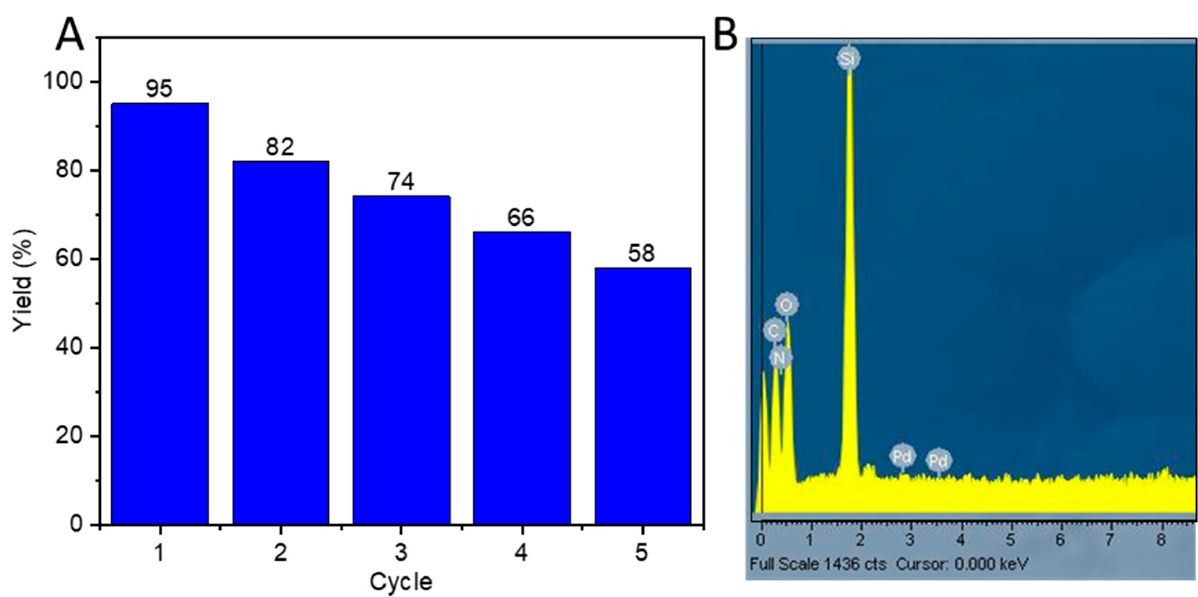
Figure 7. ( A ) Recyclability of the Pd@MO-ISO as catalyst in the chemical reduction of PNP into PAP in five consecutive cycles. ( B ) EDS spectra of PD@MO-ISO.